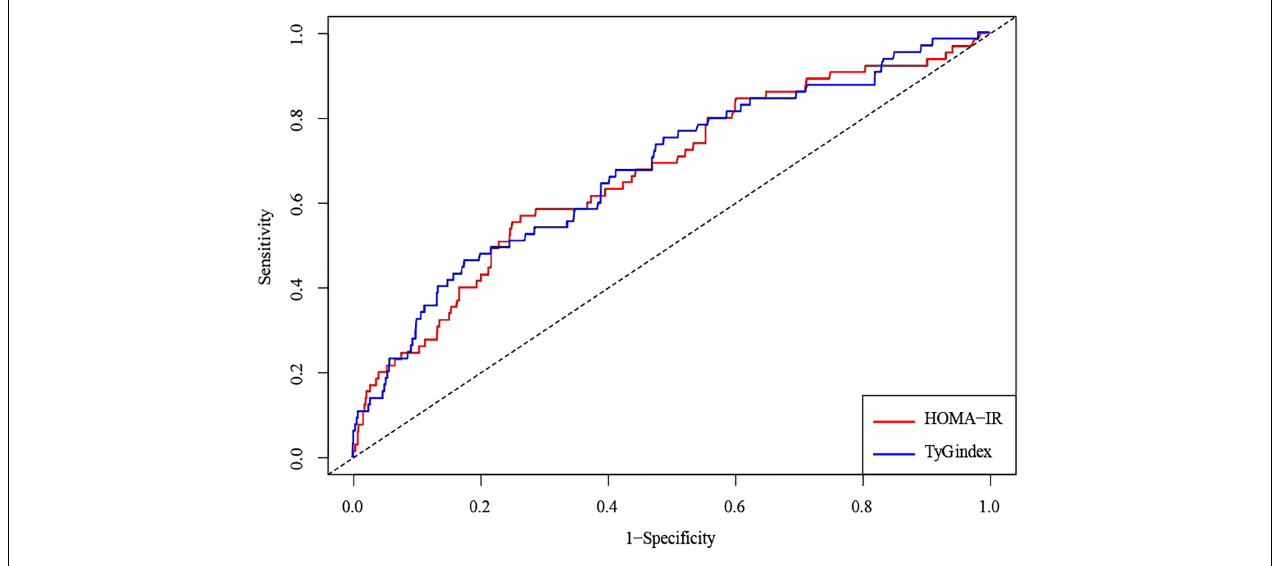
FIGURE 4 | An ROC analysis of the TyG index and HOMA-IR to predict the incident risk of CHF. A solid blue line represents the TyG index; a solid red line represents HOMA-IR. Abbreviations: ROC, receiver operating characteristic; AUC, area under the curve; TyG, Triglyceride-glucose; HOMA-IR, homeostasis model assessment-insulin resistance; CHF, congestive heart failure.